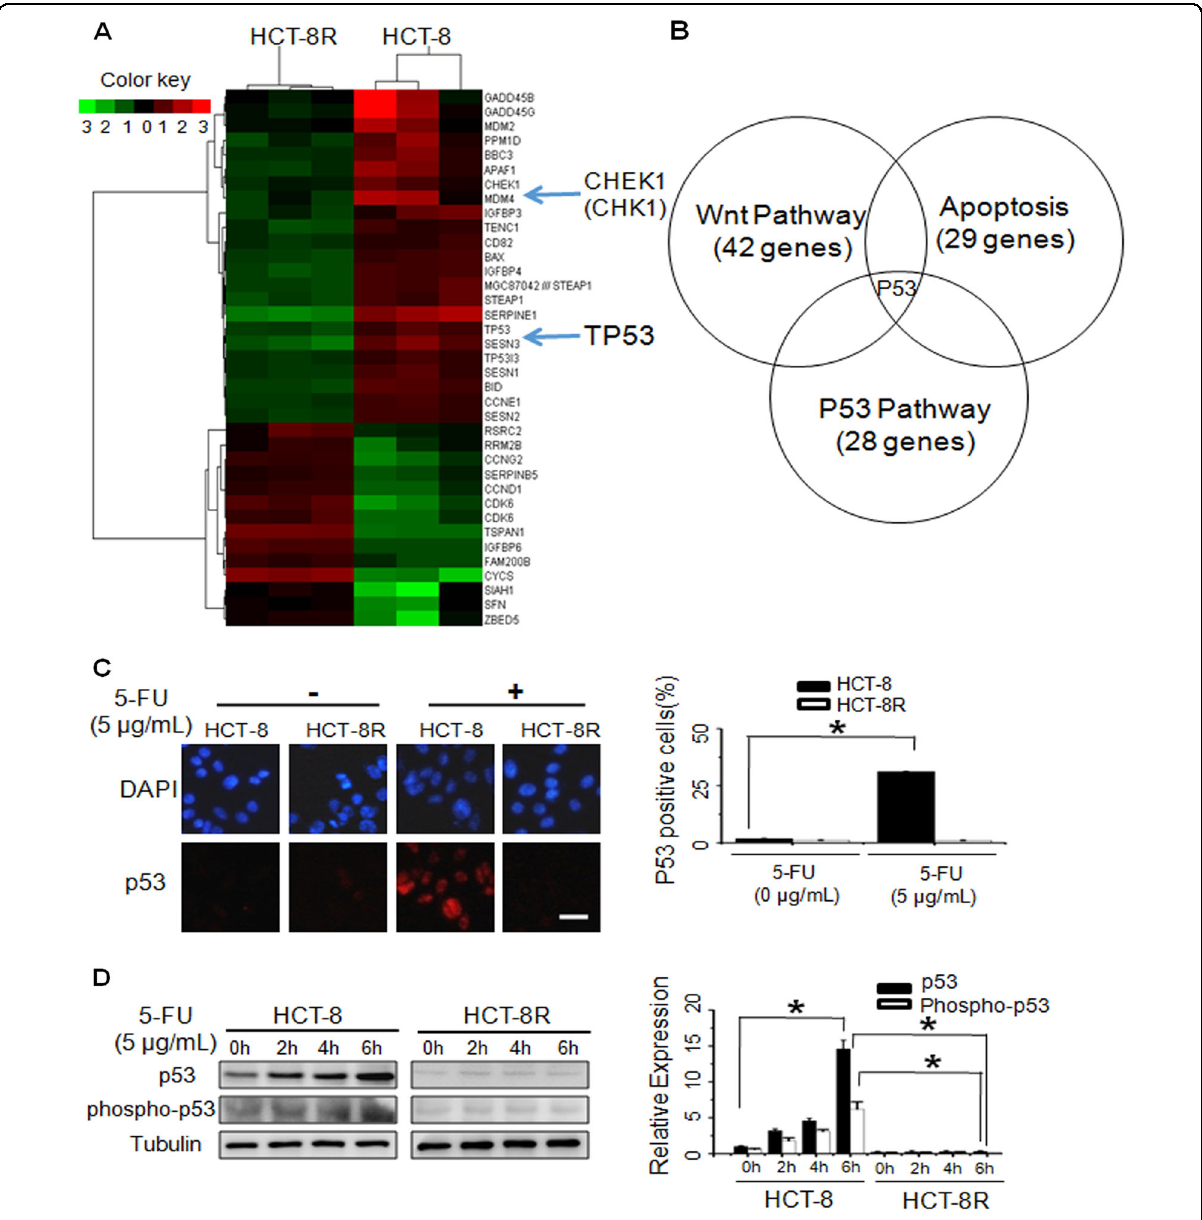
Fig. 2 Gene expression signature associated with 5-FU resistance. a Part of the hierarchical cluster diagram of HCT-8R cells vs. HCT-8 cells is shown. b Venn diagram of genes that were differentially expressed in HCT-8R cells. The gene expression fi le and KEGG analysis results of the p53- related apoptosis pathway, cell cycle regulation pathway, and Wnt pathway were analyzed. c The 5-FU-induced expression of p53 was examined by immunostaining. Shown are the representative images of 5-FU-treated HCT-8 or HCT-8R cells. Scale bar, 50 µm. The data represent the means ± SD from three independent experiments. * P < 0.05. d The induction of p53 expression in 5-FU-treated HCT-8 cells was con fi rmed by immunoblot. The 10 µg/mL 5-FU treatment induced p53 expression in HCT-8 WT cells but not in HCT-8R cells. * P <